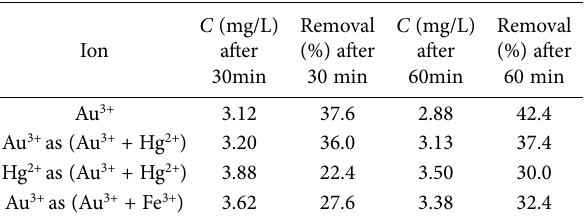
Table 7. Comparison of removal rates of Au 3+ and Hg 2+ in binary mixtures of heavy metal ions (each initially at 5mg/L) using the batch ion flotation process with N-octanoyl-cys surfactant at an ini- tial concentration of C surfactant =0.01M and pH=8.